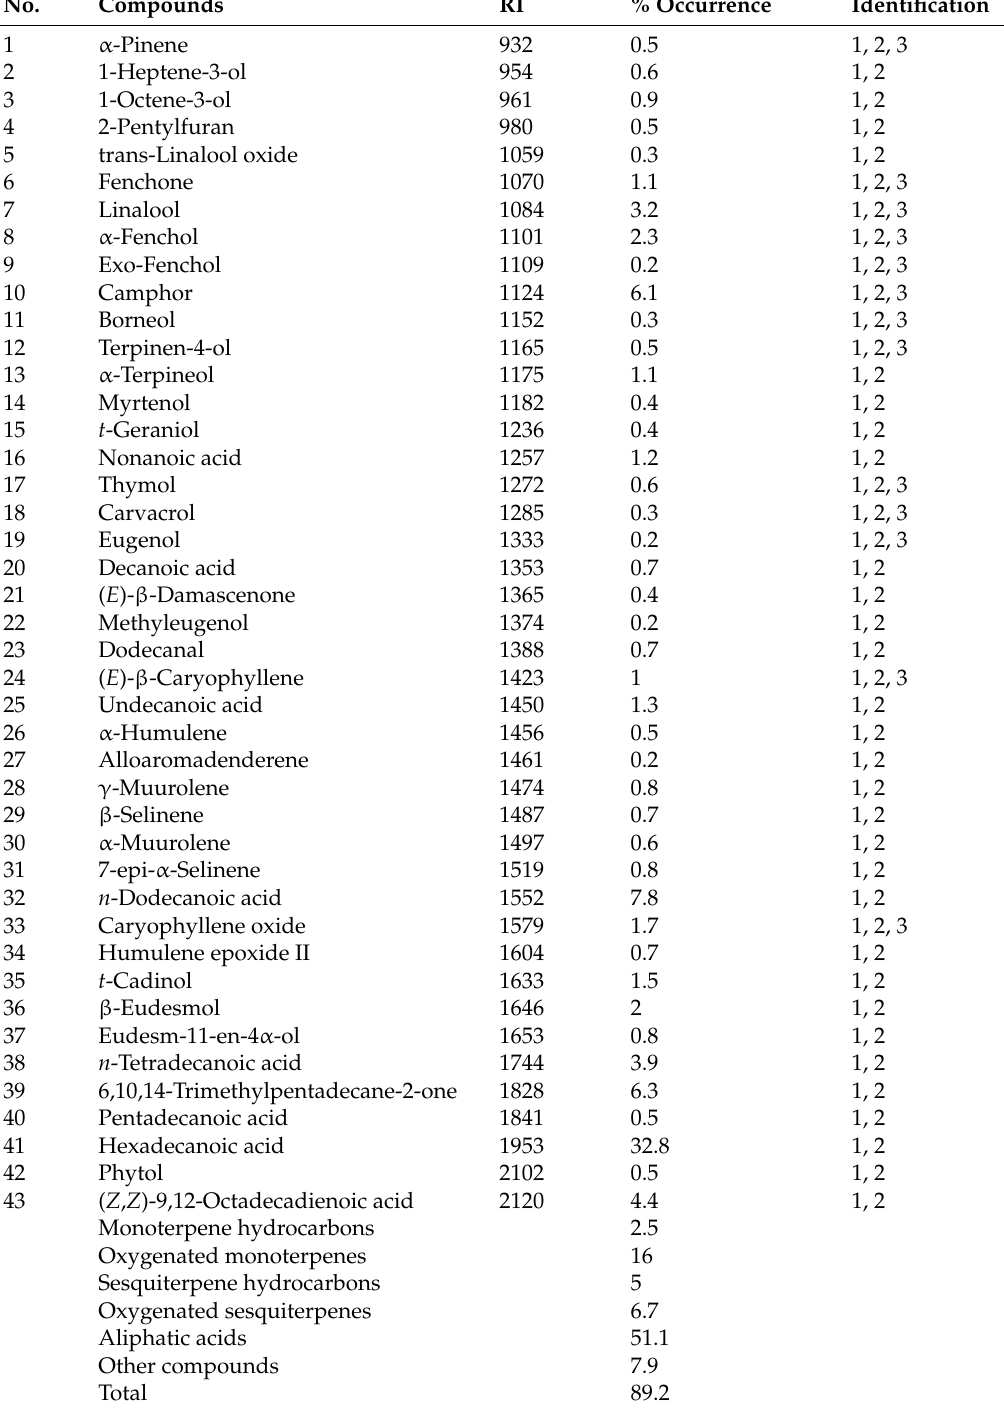
Table 1. Chemical composition of the essential oil of Leucas inflata